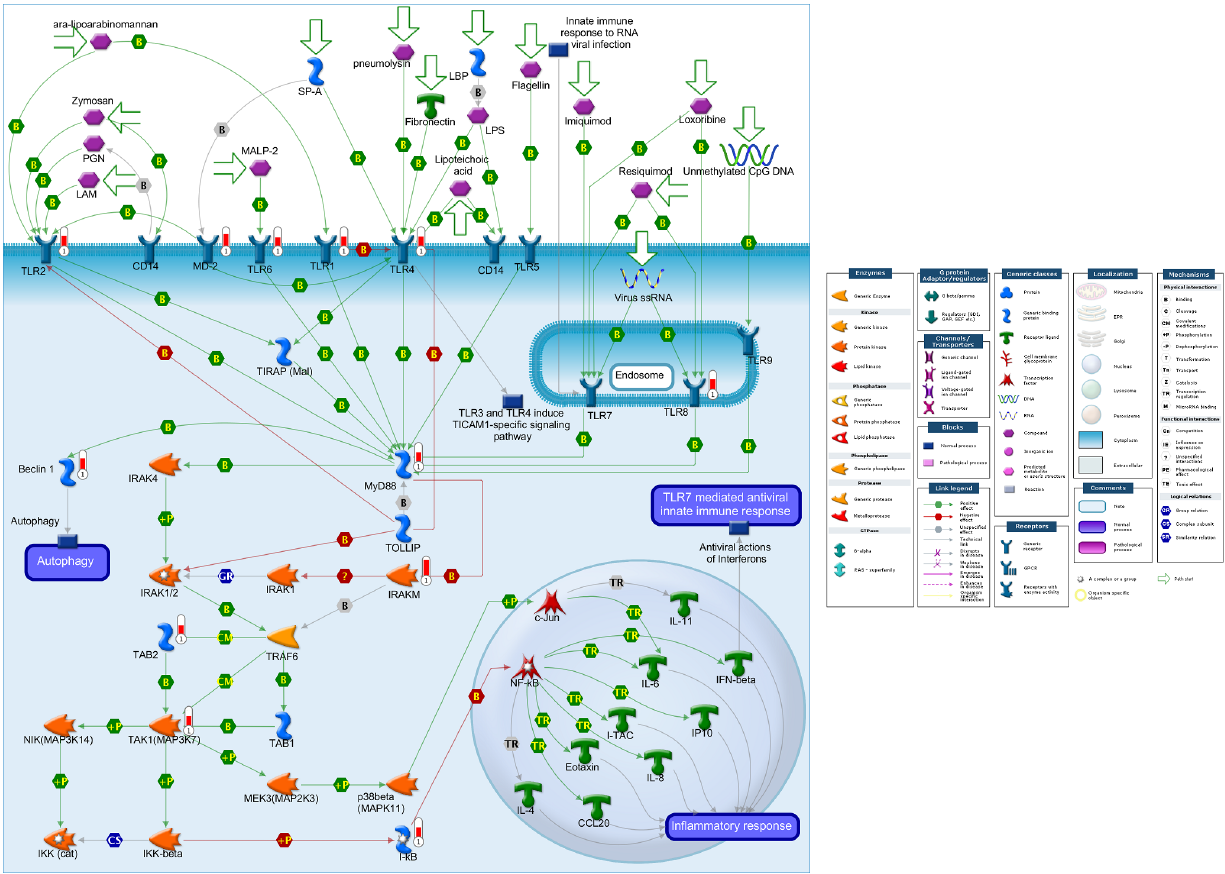
Figure 1. Differentially expressed genes associated with Toll-Like Receptor signaling pathways. The pathway illustration was generated and linked with available experimental data in the MetaCore TM suite. Twelve genes ( TLR1, TLR2, TLR4, TLR6, TLR8, MYD88, MD-2, Beclin 1, TAB2, TAK1, IRAKM and IkB) that up-regulated in the CRC patients are linked to Toll-Like Receptor signaling pathways and can be visualized on the map as thermometer-like figures. Up-ward thermometers have a red color and indicate up-regulated levels of gene expression in the CRC patients. doi:10.1371/journal.pone.0062870.g001 PLOS ONE |